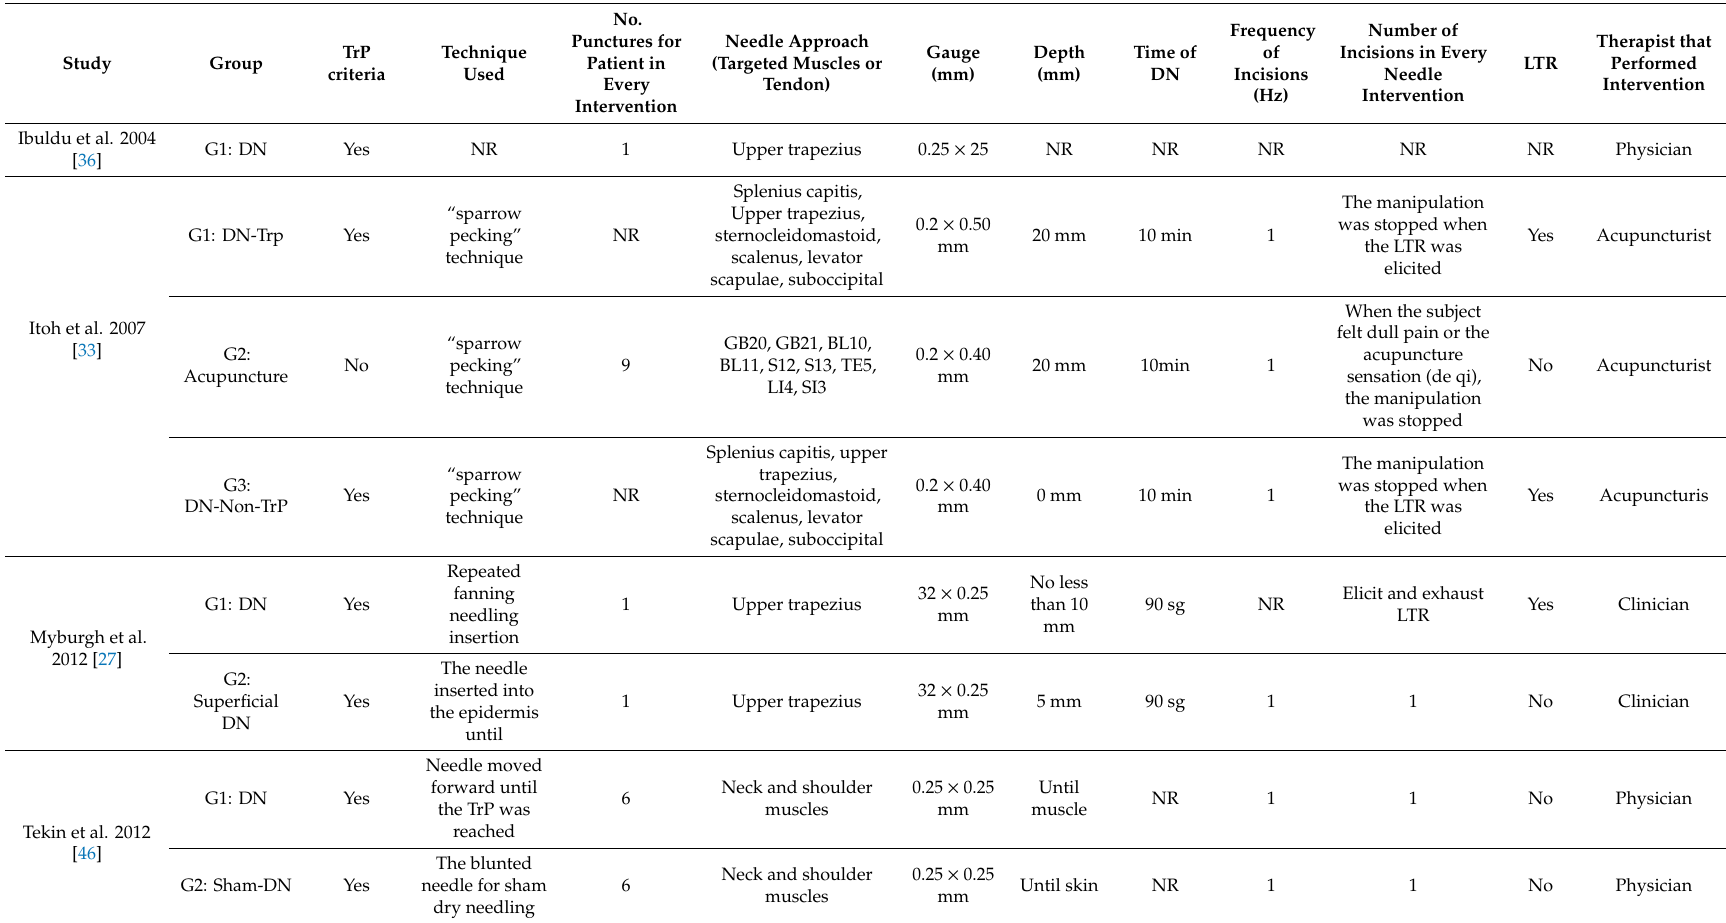
Table 3. Characteristics of the dry needling intervention of the included